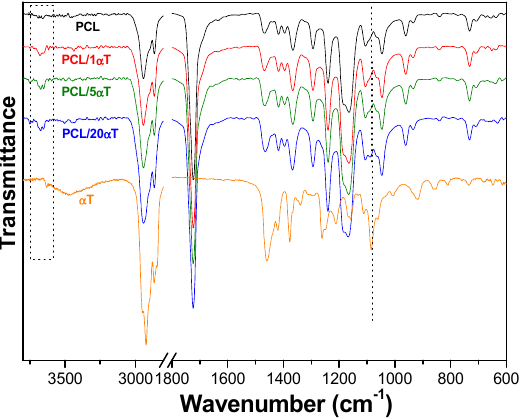
Figure 4. ATR-FTIR spectra of the PCL solutions with various α -tocopherol content.